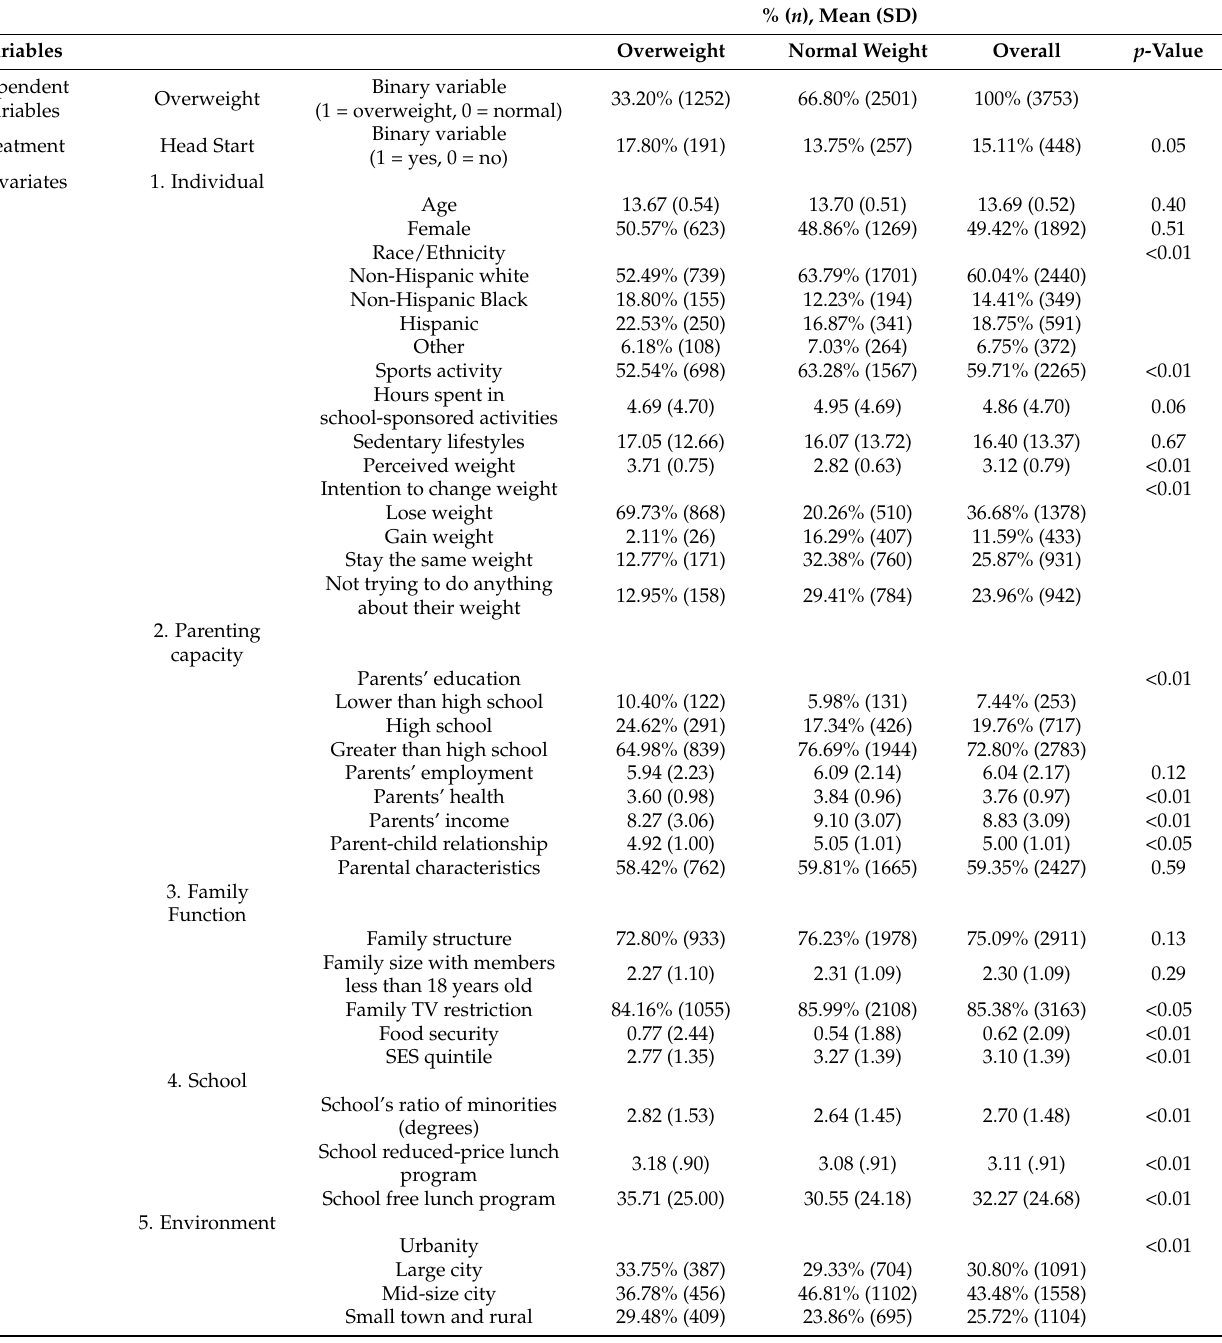
Table 2. Weighted descriptive statistics of study sample with overweight